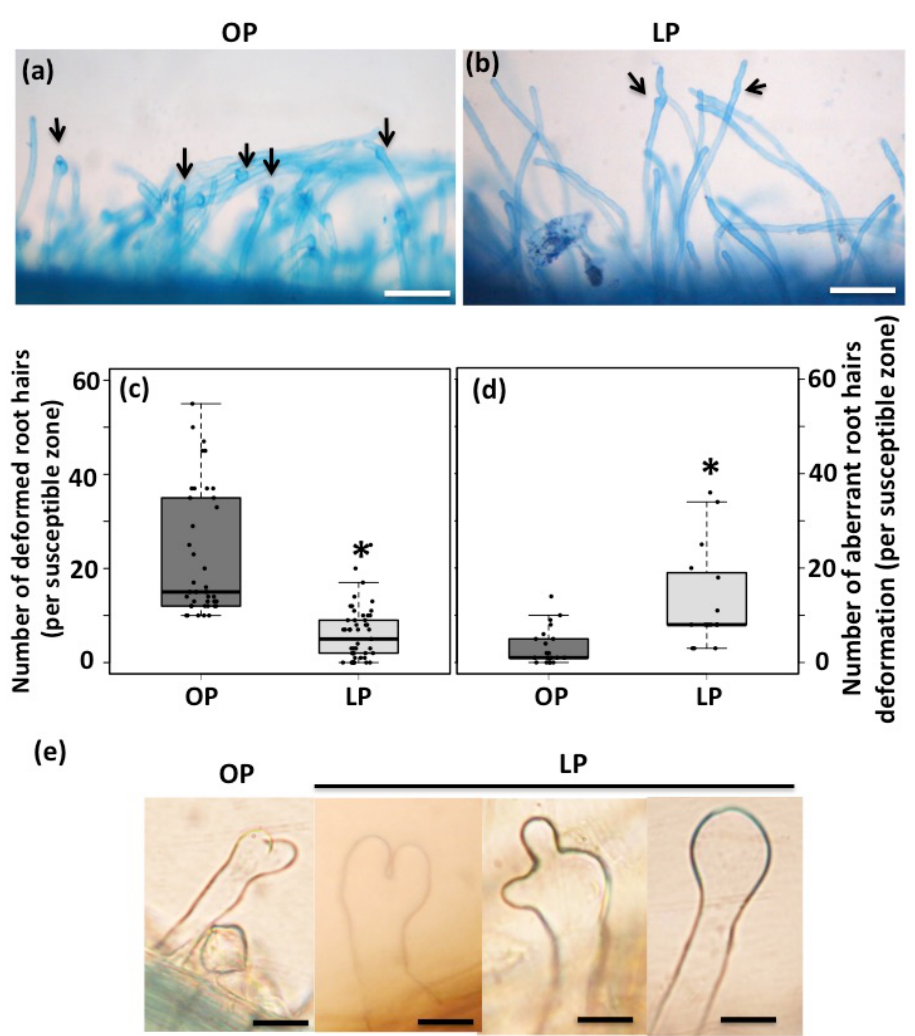
Figure 1. Pi deficiency negatively affects the rhizobia-induced root hairs deformation in common bean. Rhizobia-induced root hairs in common bean seedling growing under optimal-phosphate (Pi) (OP) ( a ) or low-Pi (LP) conditions ( b ). Scale bars in panel represent 100 µ m. Arrows indicate some examples of the rhizobia-induced root hairs observed in both OP or LP conditions ( c ) Number of rhizobia-induced root hair deformation in common bean seedlings growing under OP conditions or LP conditions. ( d ) Number of aberrant rhizobia-induced root hair deformations in common bean seedlings growing under OP conditions or LP conditions. Box plots represent first and third quartile (horizontal box side), minimum and maximum (outside whiskers). Asterisk indicates a significant difference according to one-way analysis of variance (ANOVA) ( p -value < 0.001). Data showed was obtained from 20 biological replicates, each one containing 10 roots from different common bean seedlings. ( e ) Types of aberrant rhizobia-induced root hair deformation observed in common bean seedlings growing under LP conditions. Scale bars in panel represent 50 µ m.